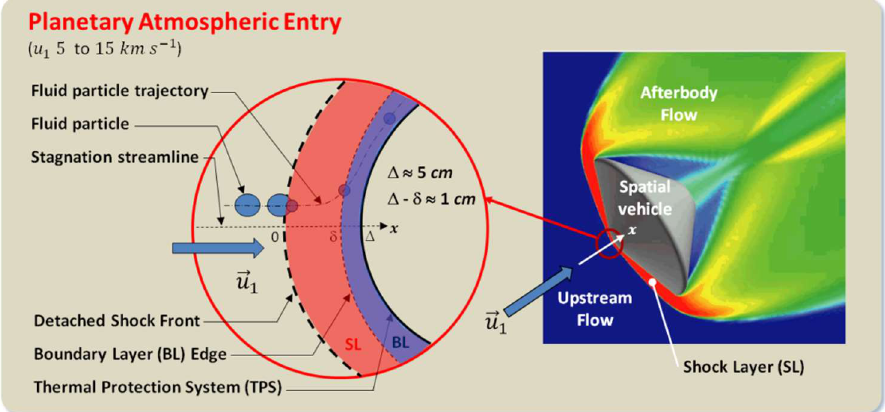
Figure 1. Global situation close to the TPS of a spatial vehicle showing the structure of the shock layer, the motion of fluid particles and the boundary layer. ∆ is the typical thickness of the shock layer and ∆ − δ the one of the boundary layer.